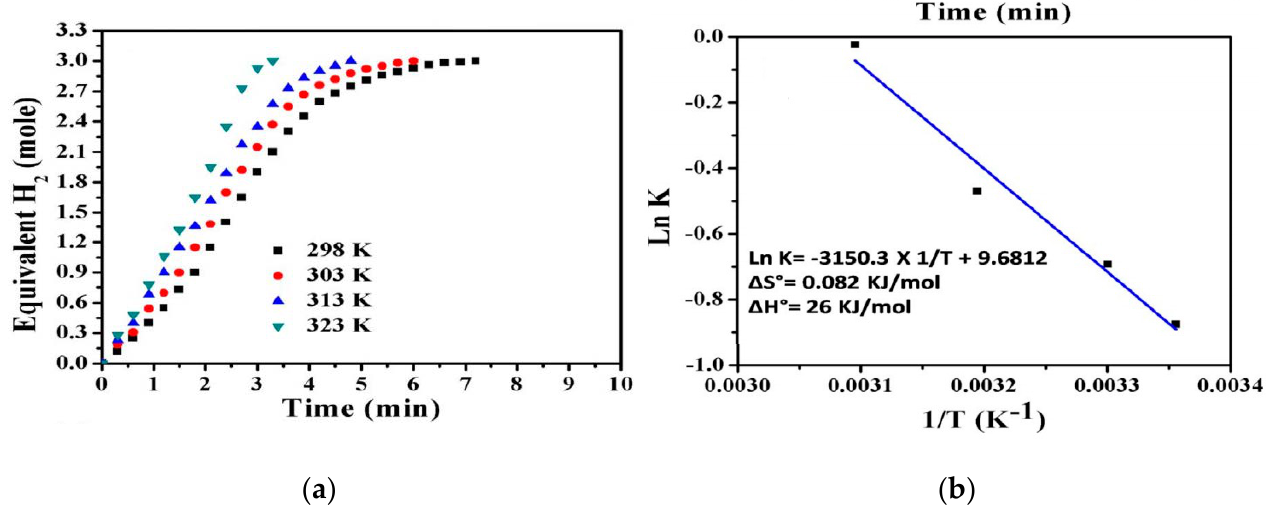
Figure 9. ( a ) Effect of temperature on Co-TiC/C NFs catalyst in hydrolysis AB reaction; ( b ) Plot of ln K vs. (1/T). Reprinted from reference [96] with permission from Elsevier.